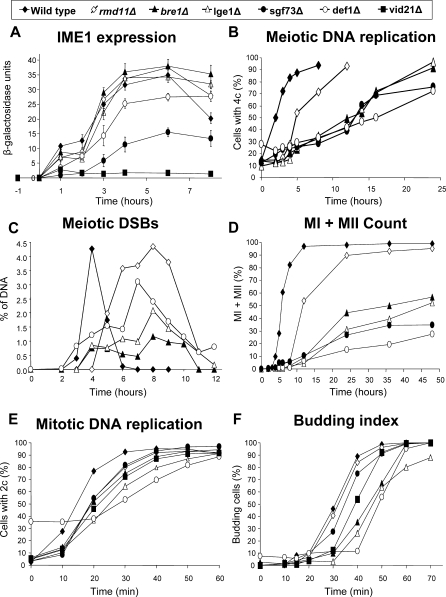
Further Characterization of VID21, BRE1, LGE1, RMD11, SGF73, and DEF1
Mutants for these genes were made in an SK1 background. The plots on each graph represent wild type (black diamonds), rmd11Δ (white diamonds), bre1Δ (black triangles), lge1Δ (white triangles), sgf73Δ (black circles), def1Δ (white circles), and vid21Δ (black squares). Where error bars are not shown, the time courses are of individual experiments. A total of three experiments were carried out in each case and the data shown are consistent with those obtained in the other experiments.(A) The expression of IME1, a primary transcription factor required for entry into the meiotic cell cycle was assessed. SK1 strains carrying a plasmid that expresses the lacZ reporter gene under the control of the IME1 promoter were grown for synchronous meioses and assessed for lacZ expression via β-galactosidase activity [92]. W303 MAT-a mutant strains for the above genes were assessed for G1 to S phase transition in mitosis after release from α-factor arrest [87].(B) Pre-meiotic DNA replication was assessed for synchronized meiotic cultures by FACS and the change from 2c to 4c DNA content was plotted over time. See Figure S2 for the raw data of the FACS analysis for meiotic DNA replication.(C) DNA extractions from sporulation time courses were digested with BglII and meiotic DSB formation (DSBIII and IV) at the THR4 hotspot was assessed using Southern blotting and probing techniques [46]. See Figure S3 for the THR4 Southern blots.(D) Nuclear divisions (MI and MII) of the synchronized meiotic cultures in (A) were assessed with fluorescence microscopy using DAPI staining to visualize nuclear division.(E) DNA replication following release from α-factor arrest was assessed via FACS and the change from 1c to 2c DNA content was plotted against time. See Figure S4 for the raw data of the FACS analysis for mitotic DNA replication.(F) The budding index of cells released from α-factor synchrony was assessed by phase contrast microscopy.